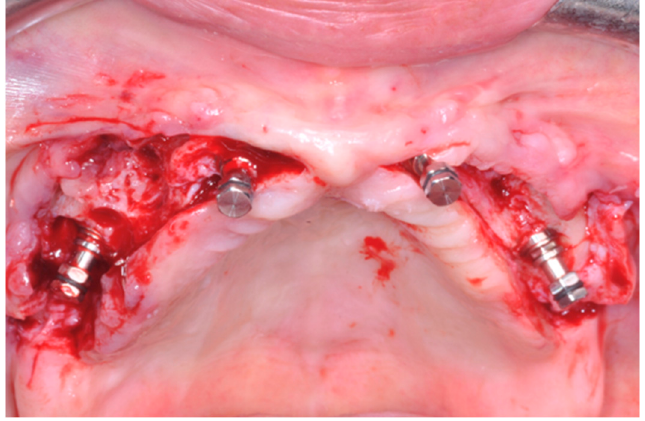
Figure 1. Four implants were placed, the distal ones being distally tilted.